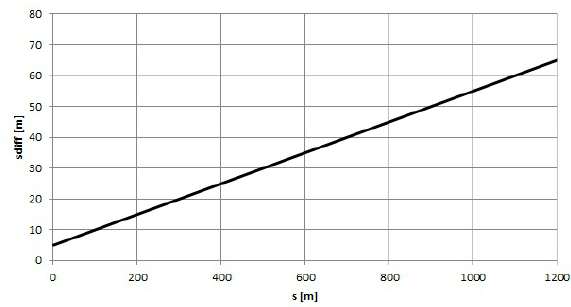
Figure 1. Required odometry accuracy